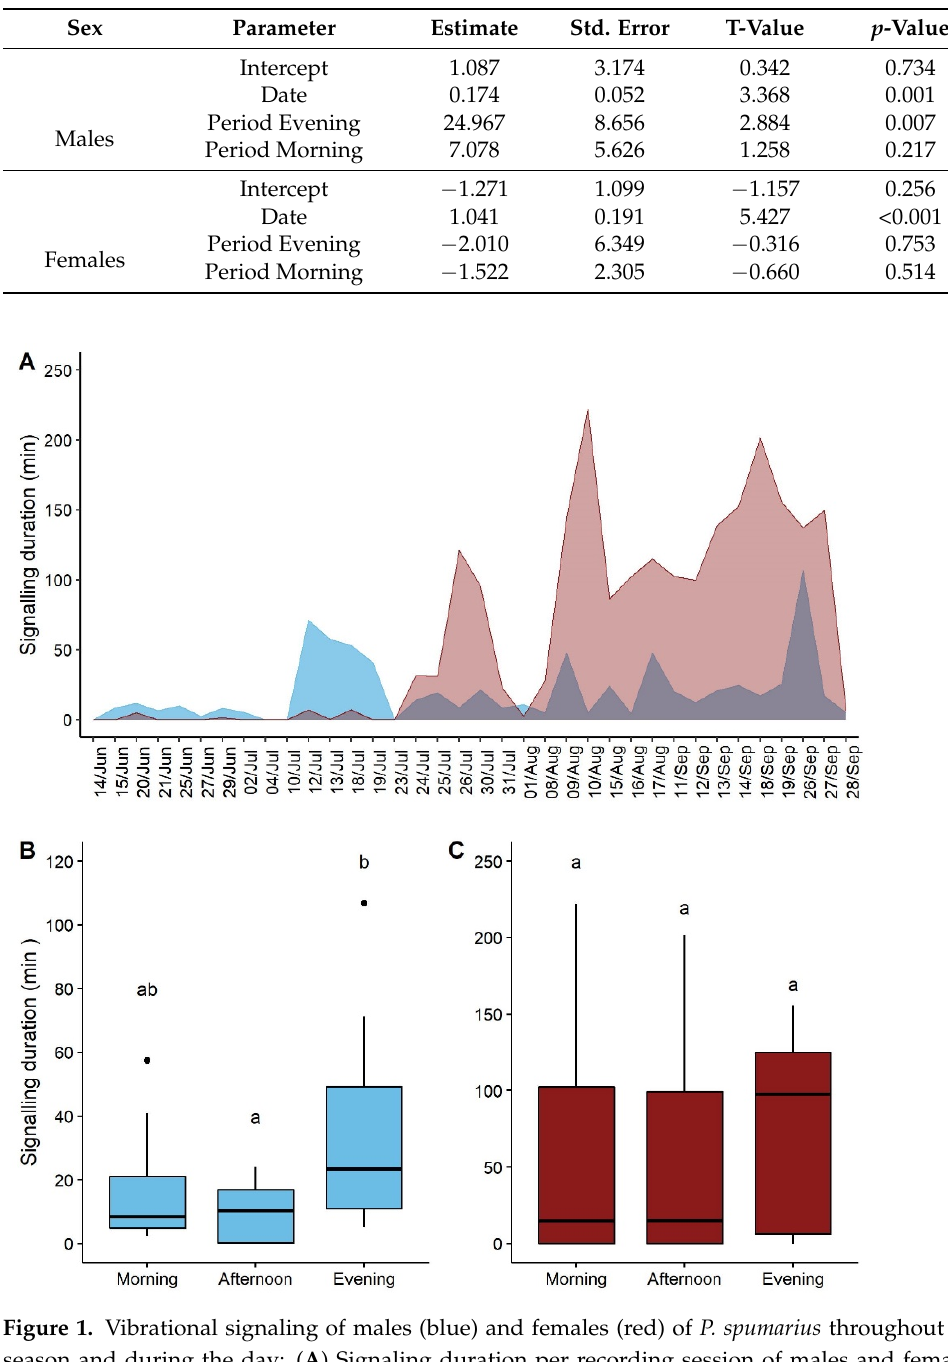
Table 1. Estimated regression coefficients, standard error, z ratio and p -value from the gls model testing the effect of date and period of the day on the number of signals. The intercept corresponds to the period afternoon.